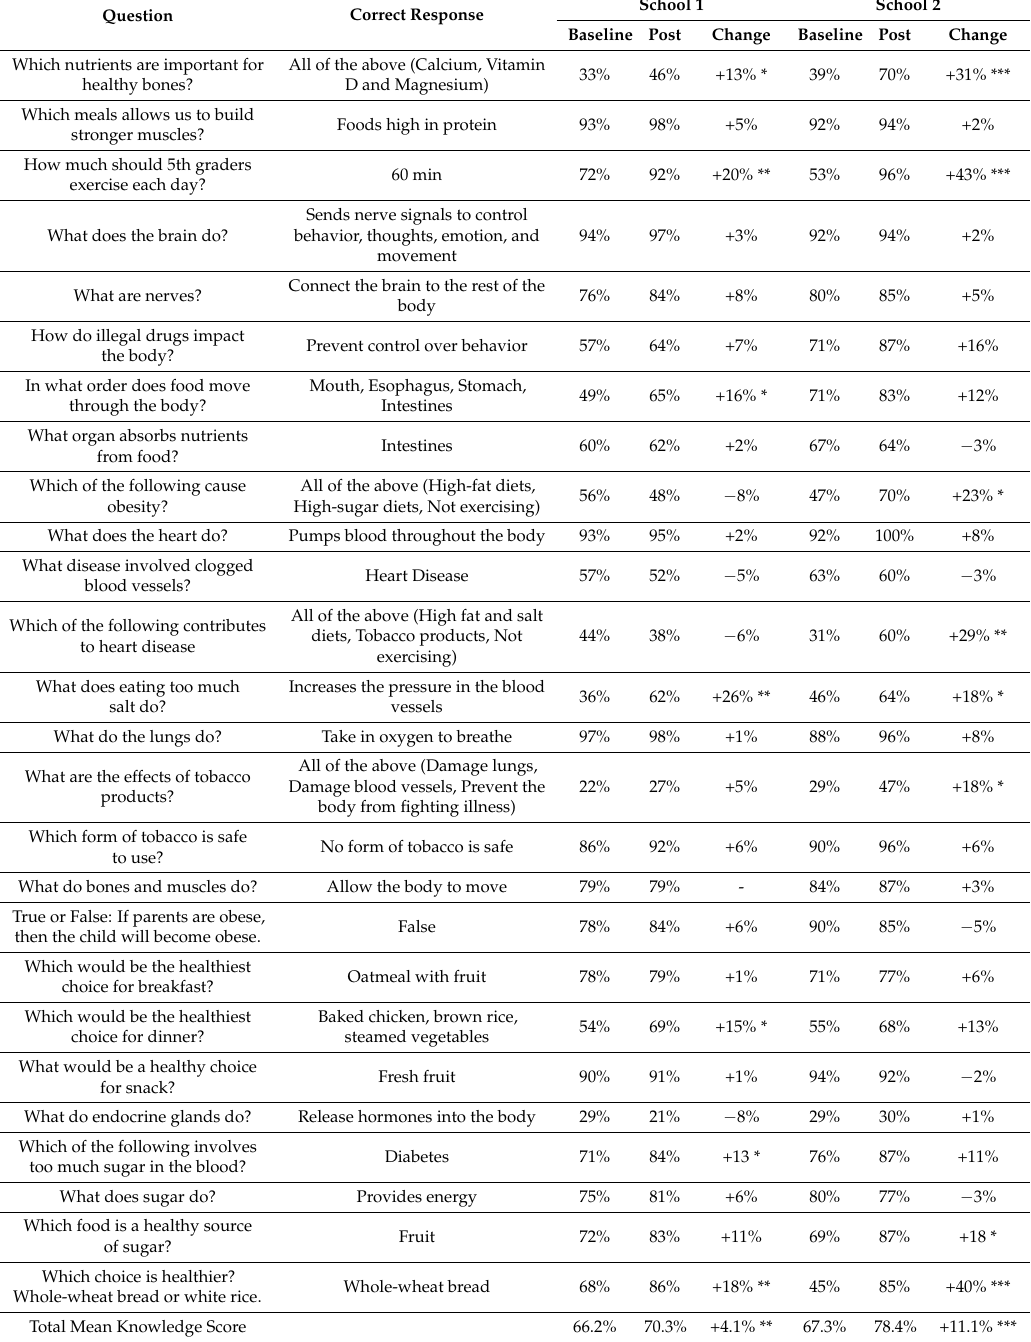
Table 1. Knowledge survey correct response change from baseline to post intervention at school 1 and school